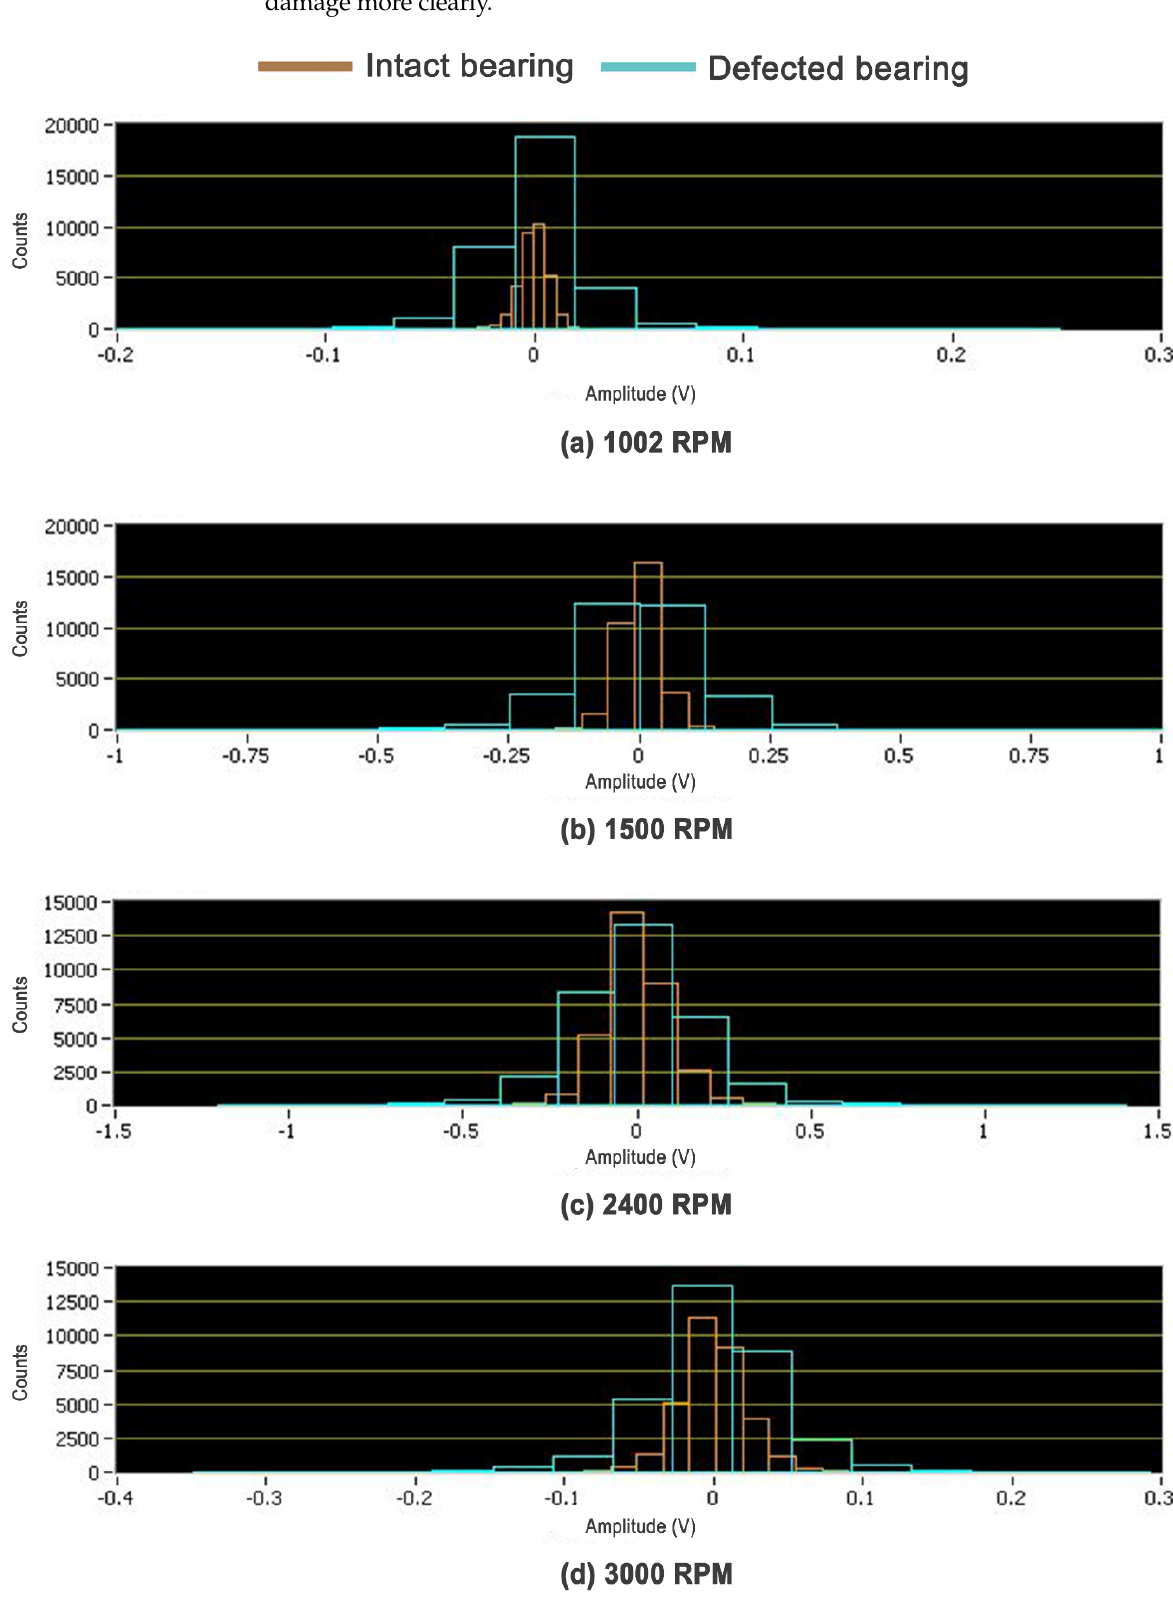
Figure 4. Histograms for an outer race damage without installing a bearing loader.